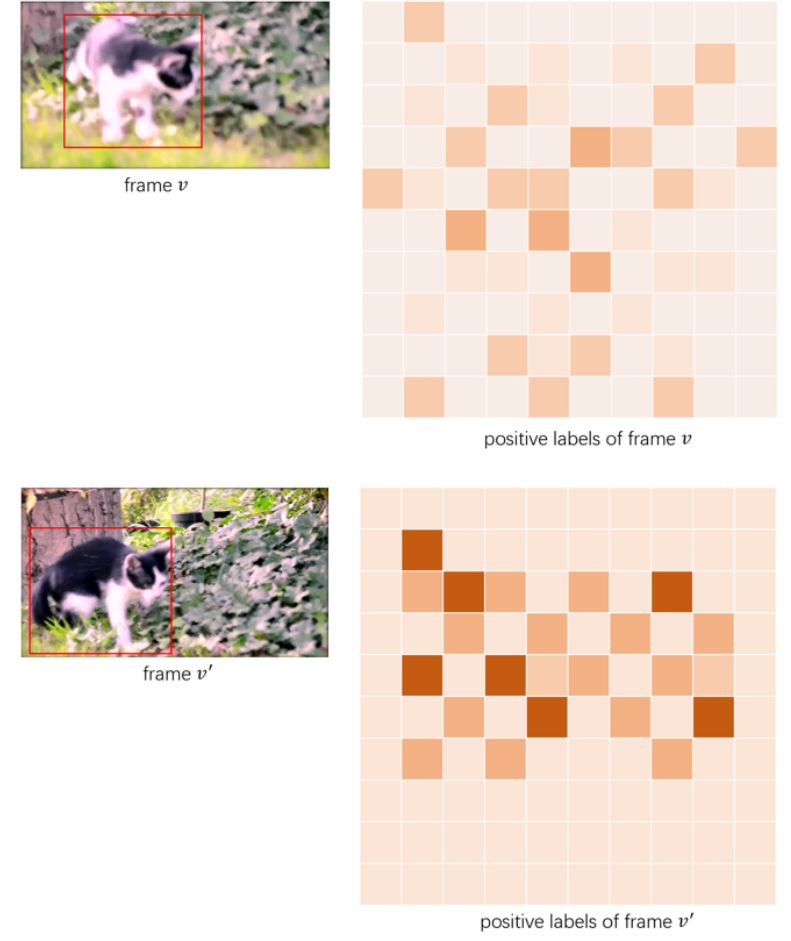
Figure 1. The visualization of the positive labels produced by our baseline (without temporal information, which will be introduced in the experiment) for two frames. Frame v and frame v (cid:48) belong to the same snippet. We only show the positive labels inside the gt box, and the positive labels outside the gt box are all 0 (i.e., the samples outside the gt box cannot be positive